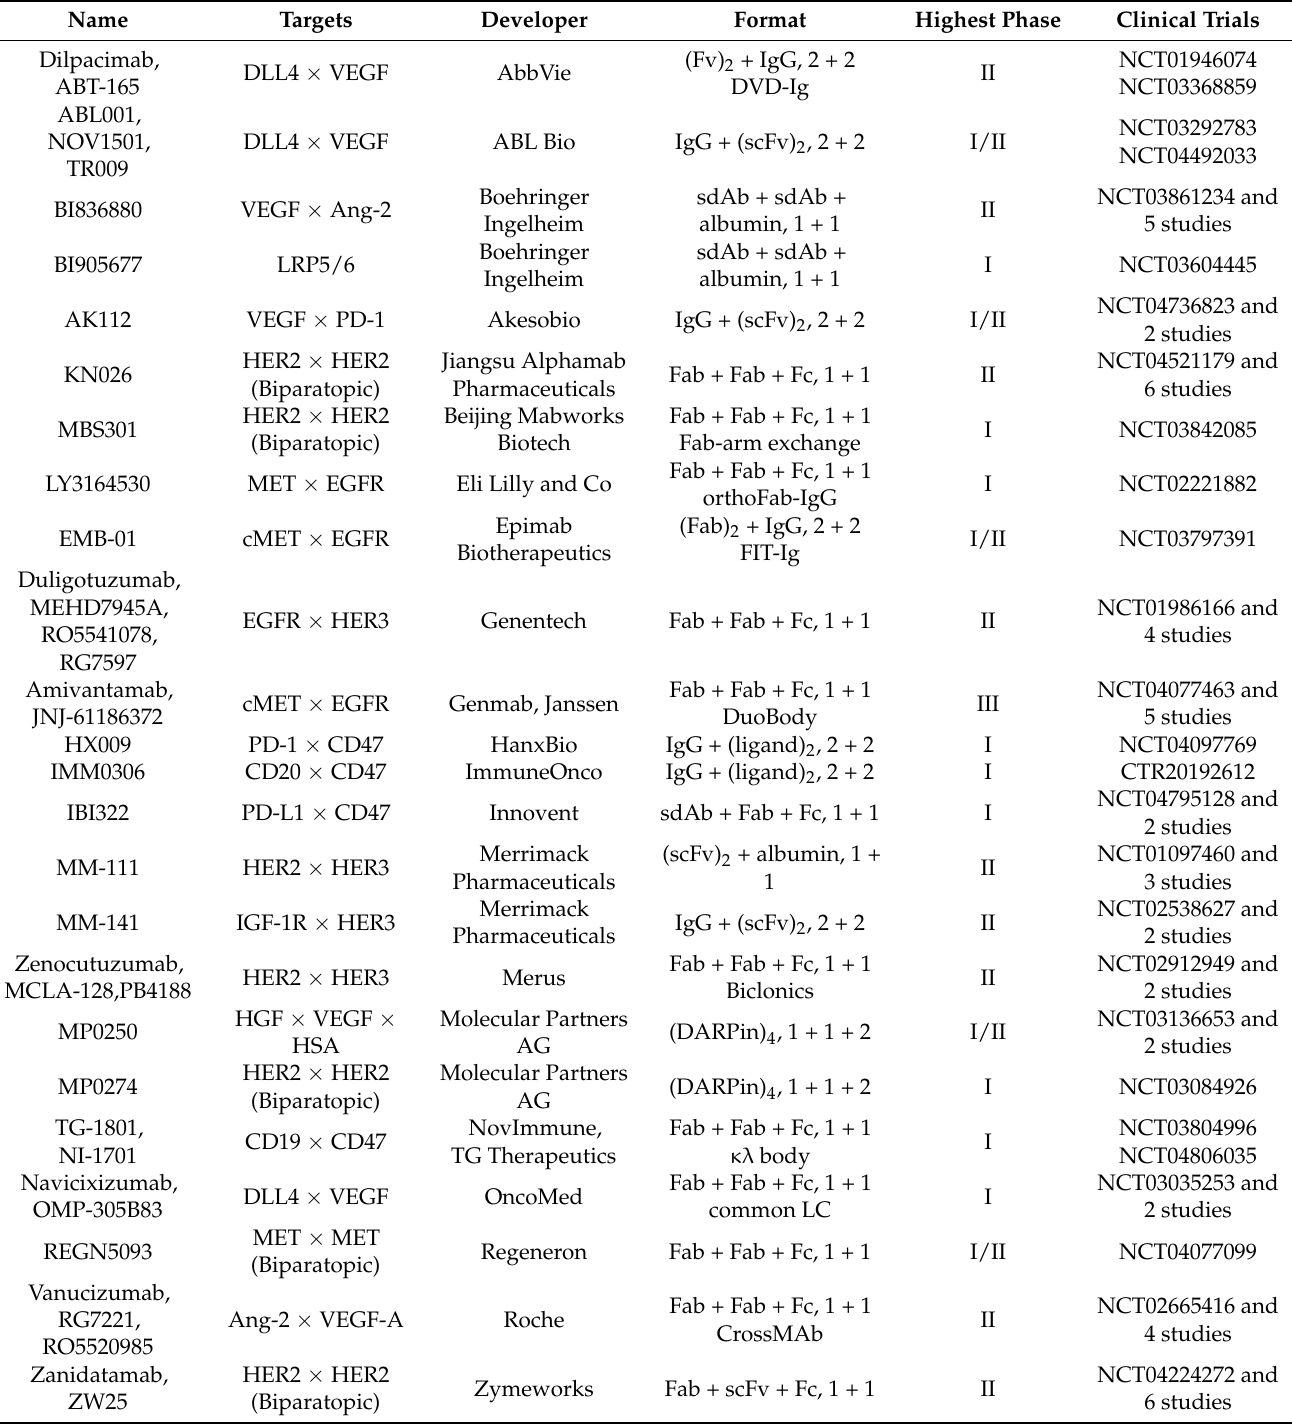
Table 4. Dual tumor-targeting BsAbs in clinical